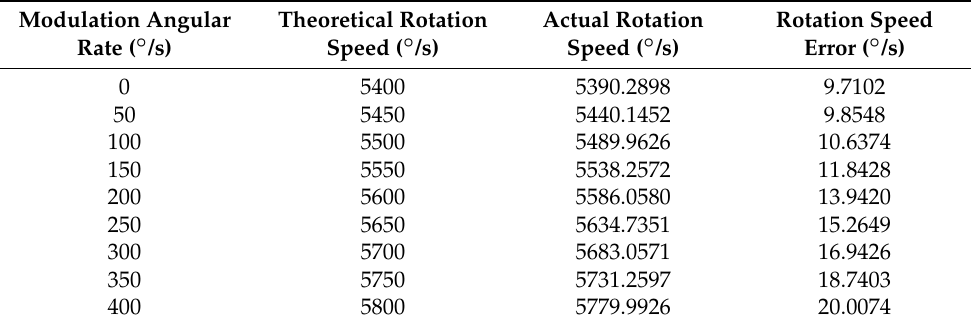
Table 1. Theoretical and practical rotation angular rate data.